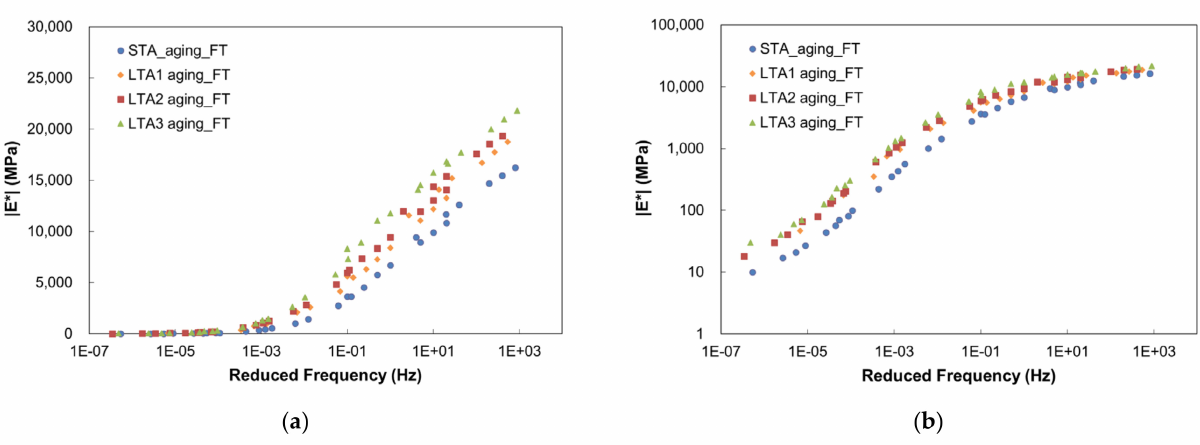
Figure 10. Dynamic modulus test results of HMA after moisture damage for each stage of aging: ( a ) dynamic modulus master curve (semi-log scale), ( b ) dynamic modulus master curve (log-log scale), ( c ) phase angle master curve, and ( d ) shift factor.